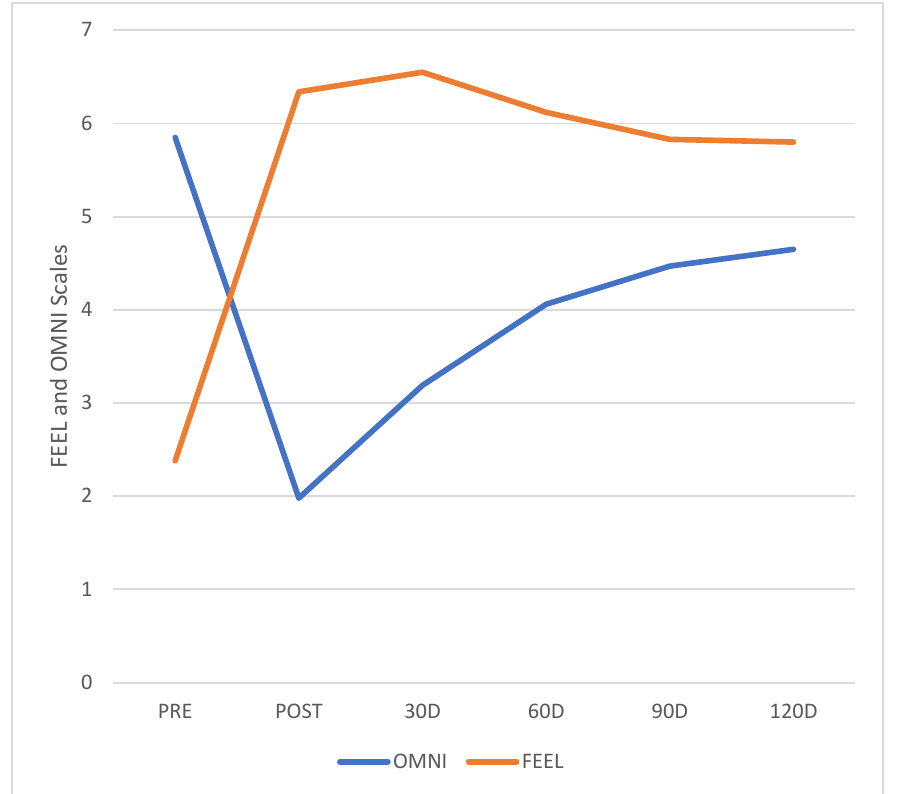
Figure 4. FEEL and OMNI Scales Values at Each Time Point.